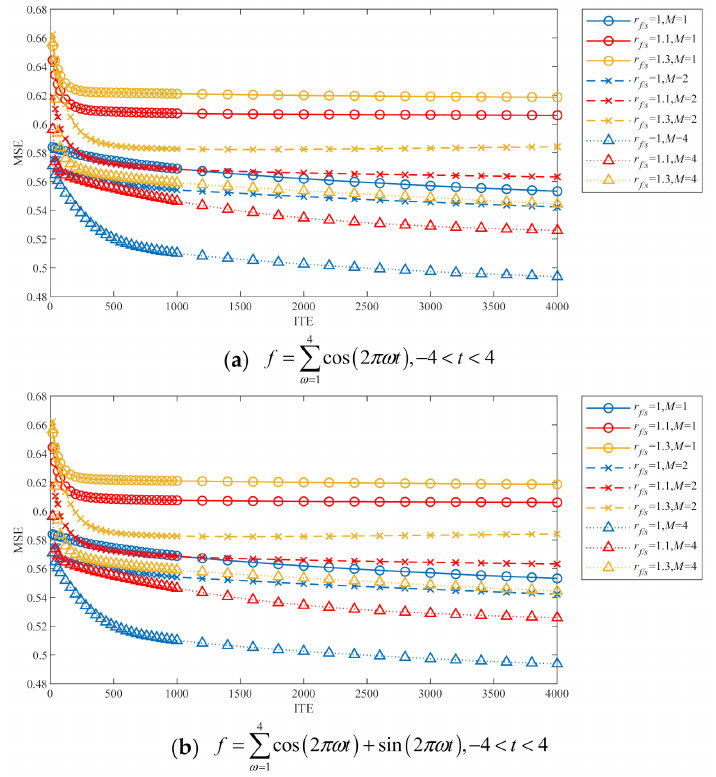
Figure 5. MSE of piecewise extrapolation for cosine and sine signals at α =